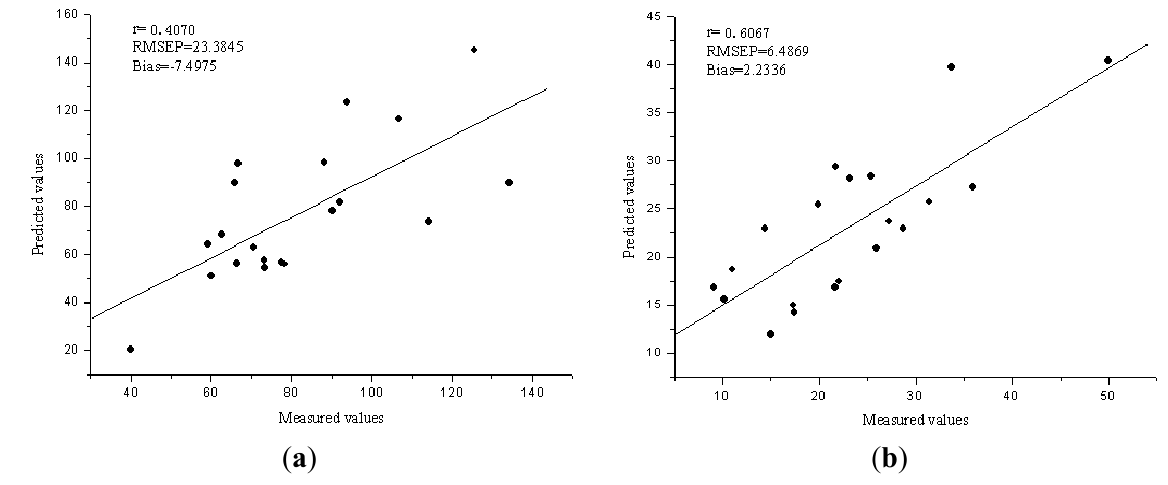
Figure 3. ( a ) The predicted versus reference values for Fe by LV-LS-SVM model. ( b ) The predicted versus reference values for Zn by LV-LS-SVM model.